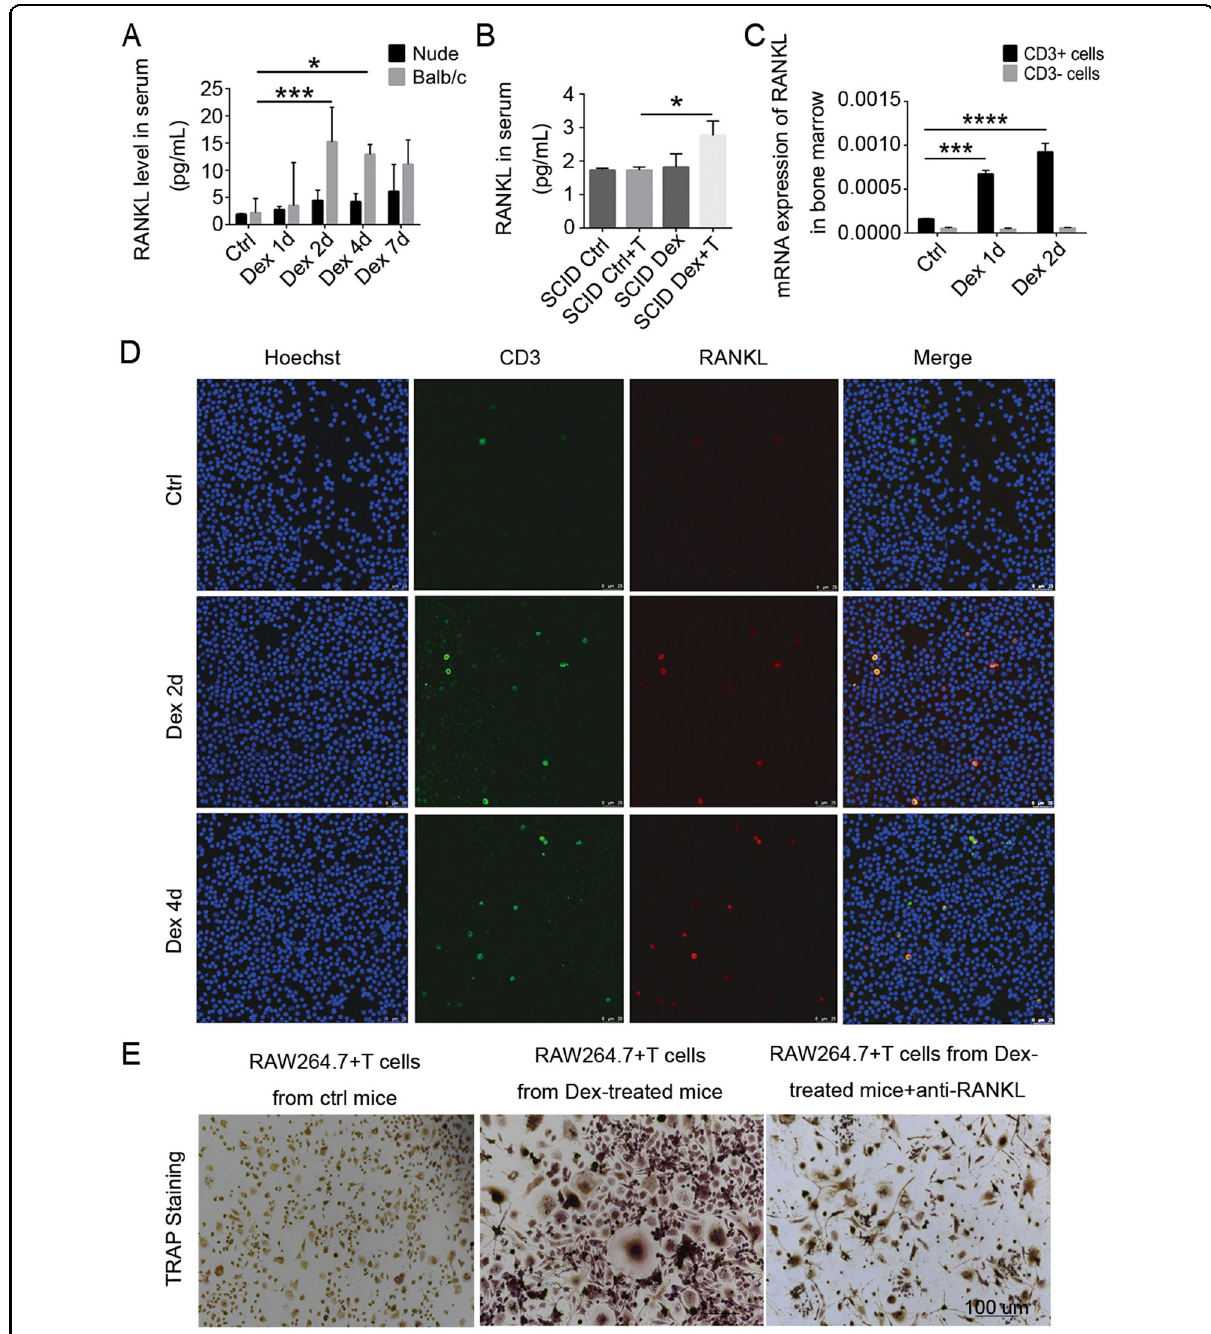
Fig. 5 Dexamethasone preferentially stimulates RANKL expression in T cells. A RANKL protein levels in serum from WT and nude mice treated with or without Dex, after 1, 2, 4, or 7 days ( n = 4). B RANKL protein levels in serum from SCID mice with or without T-cell reconstitution, treated with or without Dex for 4 weeks ( n = 5). Bars represent mean ± SD. C CD3 + and CD3 − cells were isolated from bone marrow 1 or 2 days after Dex injection, and RANKL mRNA levels (relative to beta-actin) were analyzed by Q-PCR. D Immuno fl uorescence staining of CD3 and RANKL in bone marrow cells from WT mice treated with or without Dex. Scale bar, 25 μ m. E Bone marrow T cells from mice treated with or without Dex were isolated, and cocultured with the mouse monocyte/macrophage cell line RAW264.7 and M-CSF for 10 days. The RAW264.7 cells were then stained for tartrate-resistant acid phosphatase to identify osteoclasts and a nuclear counterstain. Scale bar, 100 μ